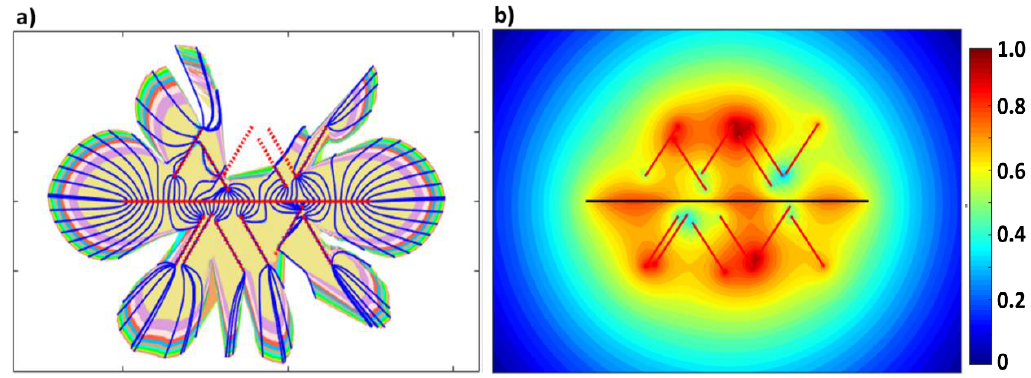
Figure 12. ( a ) DRV generated with upscaled natural fractures using field data from HFTS; hydraulic fracture in red; streamlines in blue; natural fractures in dashed red lines. Rainbow colored fill shows drained areas after 3-year time periods. ( b ) Pressure plot after 1 month production generated from CAM around single hydraulic fracture with HFTS upscaled natural fractures; hydraulic fracture in black; natural fractures in red; pressure scale normalized by highest pressure value.